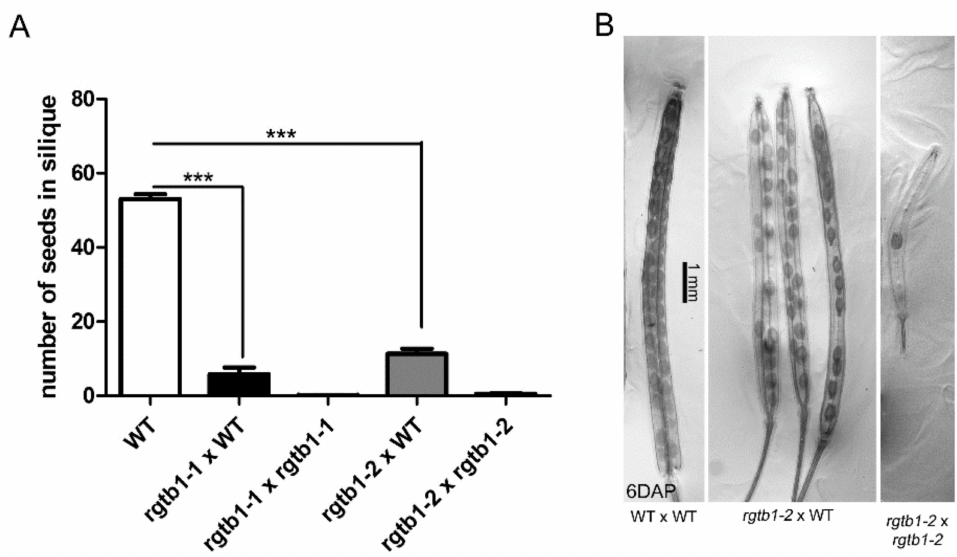
Figure 1. Number of seeds per silique is decreased in rgtb1 / rgtb1 pistils that were either left for open pollination or manually pollinated with WT pollen. ( A ) Graph showing the number of seeds per silique. Number of siliques counted: WT n = 21, rgtb1-1 × WT n = 19, rgtb1-1 × rgtb1-1 n = 12, rgtb1-2 × WT n = 34, rgtb1-2 × rgtb1-2 n = 19. Bars show mean ± SD. Values were compared with a two-sided Student t -test; *** denotes a p value < 0.001. ( B ) Siliques 6 days after hand pollination (6DAP) showed differences: WT silique filled with seeds, an intermediate situation in the rgtb1 × WT cross and a silique from a self-pollinated rgtb1 plant with only one seed. Light microscopy, representative images are shown. Scale bar represents 1 mm, common to all images. The failure of seed formation in the case of open pollination of the rgtb1 / rgtb1 plant may be due to the discrepancy in anther/pistil size [53], while poor success of hand pollination of the rgtb1 / rgtb1 may be explained by low fertility of the rgtb1 / rgtb1 -derived pollen [54]. Interestingly, the amount of seed formation in the rgtb1 / rgtb1 × WT manual cross, which on average